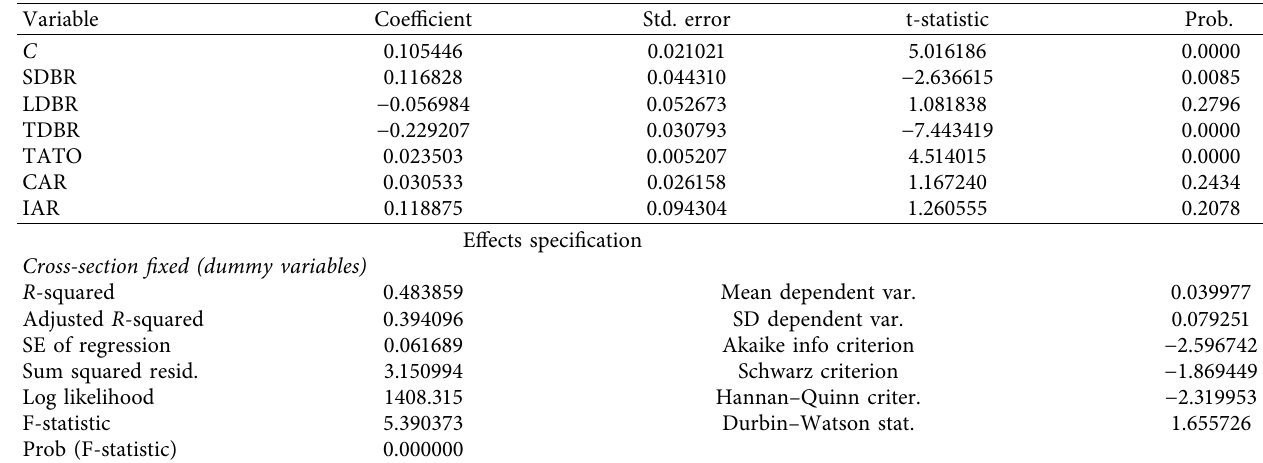
Table 5: Results of regression analysis of fixed effects